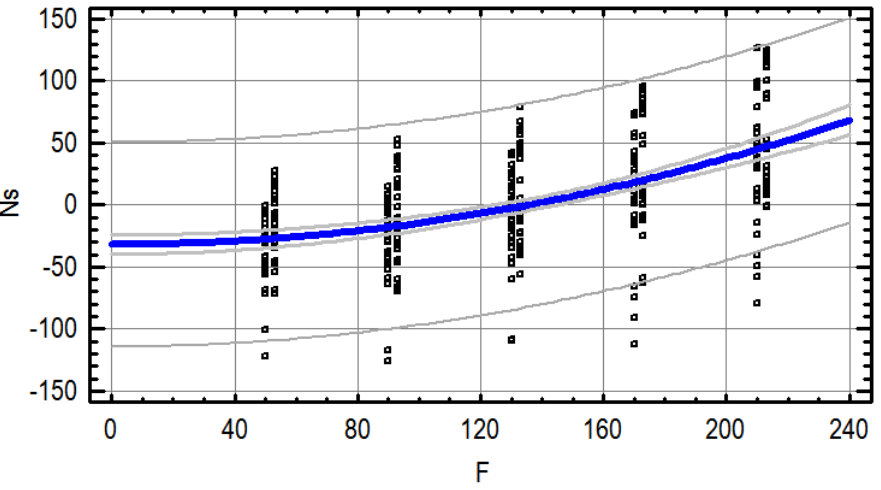
Figure 4. Observed and predicted N surplus (Ns, kg N·ha − 1 ) depending on nitrogen doses (F, kg N·ha − 1 ) (R 2 = 32.9%, n = 320) .